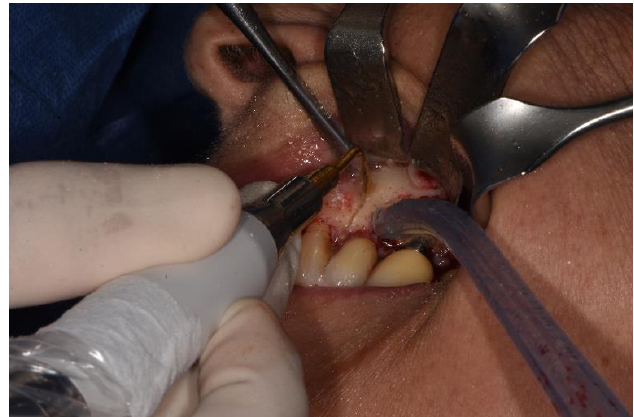
Figure 4. Osteotomy with piezoelectric device.